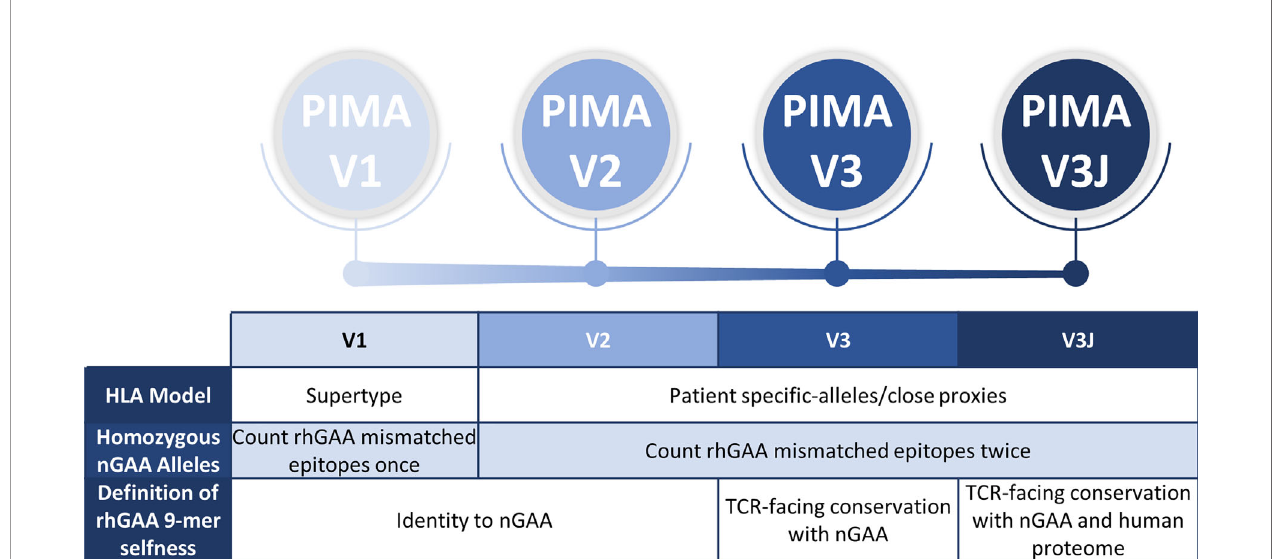
FIGURE 1 | Overview and evolution of the PIMA scoring algorithms used to calculate the ADA risk assessment score. V1 was previously published. V2-V3 are intermediate steps to developing V3J as described here. V2 added subject-speci fi c HLA DR epitope prediction, V3 added conservation with nGAA at the TCR face of epitopes, and V3J examine the potential for certain nGAA epitopes to be tolerogenic by comparing the sequence to other human genome epitopes. The most accurate for this cohort was V3J, which adjusted the prediction for T cell epitopes that are cross-conserved with other self-epitopes (not con fi ned to nGAA). In contrast to V1, where epitopes mismatched between rhGAA and nGAA of individuals with homozygous nGAA mutations were counted once, V2-V3J included mismatched epitopes twice in the calculations, once for each allele. We then identi fi ed speci fi c T cell epitopes in GAA that generated tolerance in vitro . Individual immune tolerance to nGAA sequences may diminish the risk of ERT-related